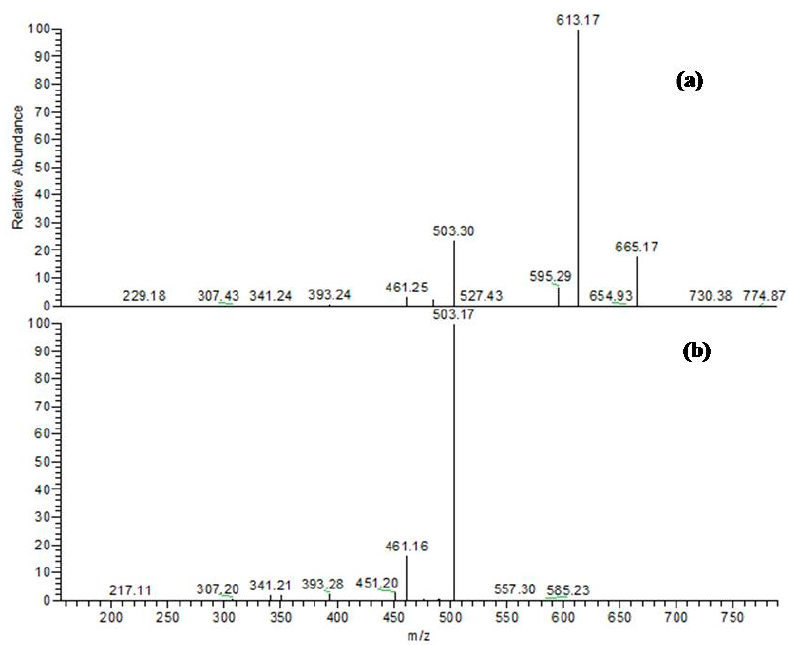
Figure 5. Negative ion ESI-MS/MS spectra of bis-dihydroxyphenylpropanoid-substituted catechin–hexoside; ( a ) MS 2 of [M − H] − m / z 775; ( b ) MS 3 of main daughter ion at m / z 613.